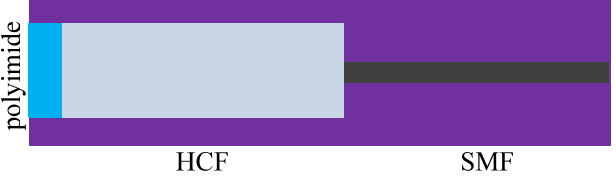
Figure 18. The configuration of the F-P consists of SMF, HCF, and polyimide [85].